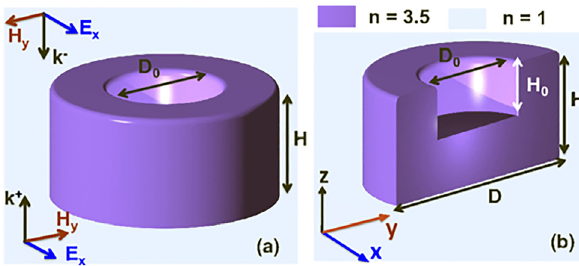
Figure 11: All-dielectric reciprocal Omega-type bianisotropic nano- particles (reprinted with permission from Ref. [77]).